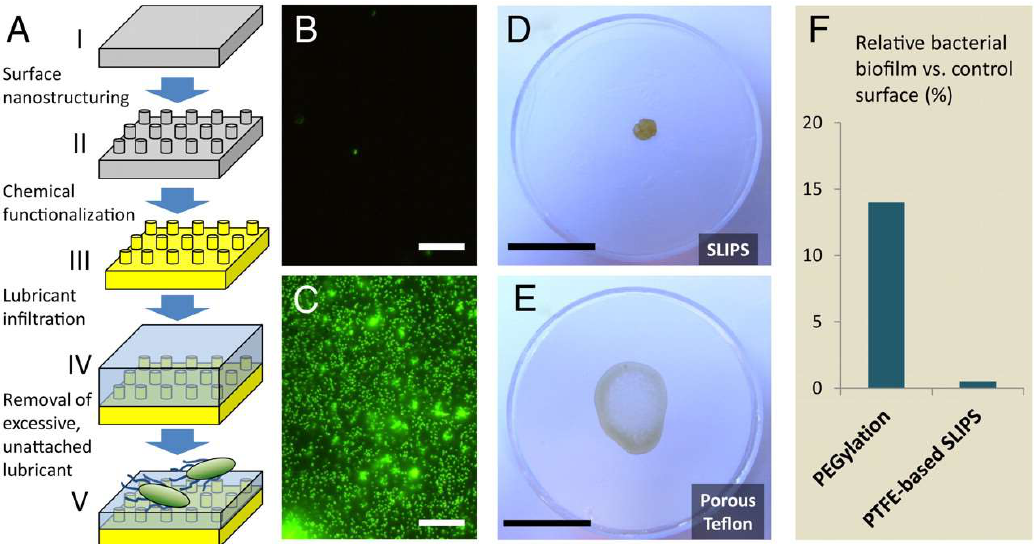
Figure 2. Visual summary of the slippery liquid-infused porous surfaces (SLIPS) approach. ( A ): SLIPS fabrication flow chart; ( B , C ): fluorescence micrographs of attached P. aeruginosa biofilm on SLIPS ( B ) and superhydrophobic Teflon ( C ) under the same conditions; ( D , E ): wetting characteristics of a drop-cast biofilm of P. aeruginosa on SLIPS ( D ; limited wetting, loosely attached and easily removable) and superhydrophobic Teflon ( E ; complete wetting, high adhesion); ( F ): comparison of biofilm attachment on a SLIPS surface (after 7 days) and on a PEGylated surface (after only 5 h), showing a 30-fold increase in anti-biofilm capacity for SLIPS against a gold-standard antifouling material. Reproduced from reference [34], with permission.